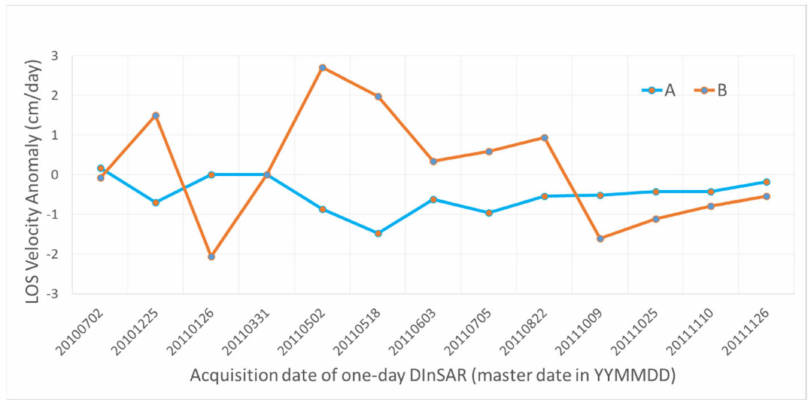
Figure 5. LOS velocity anomaly in A and B of Campbell Glacier, relative to the DInSAR pair [20100616_20100617]. The anomaly A has higher variation of LOS velocity than